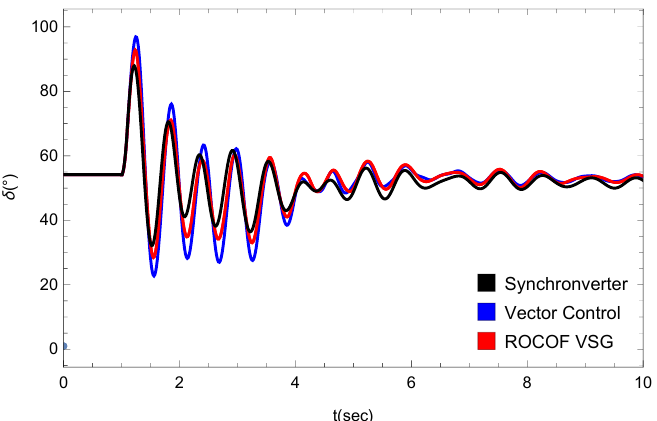
Figure 9. IEEE 9 bus: Load angle of 3 generator during 3 phase fault for t cl = 0.1 s.